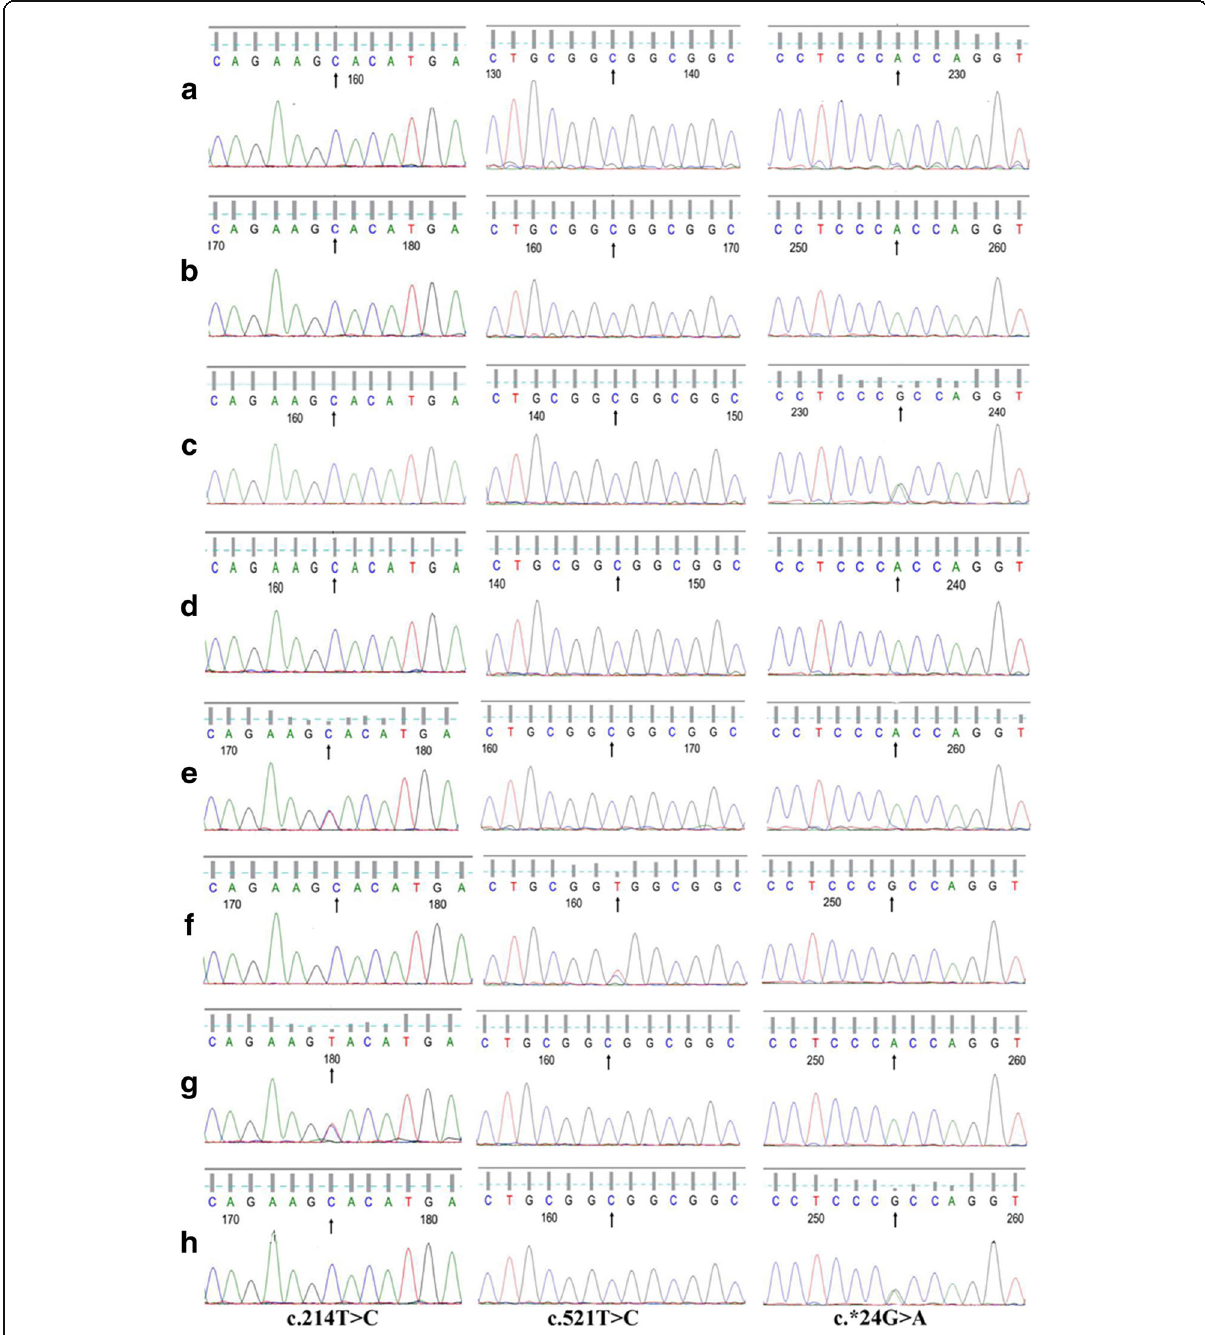
Fig. 5 Gene sequencing of CYBA. Arrows indicate the mutation points. a the patient. b the patient ’ s sister. c the patient ’ s mother. d the patient ’ s father. e the patient ’ s paternal aunt. f the patient ’ s maternal uncle. g the patient ’ s paternal grandmother. h the patient ’ s maternal